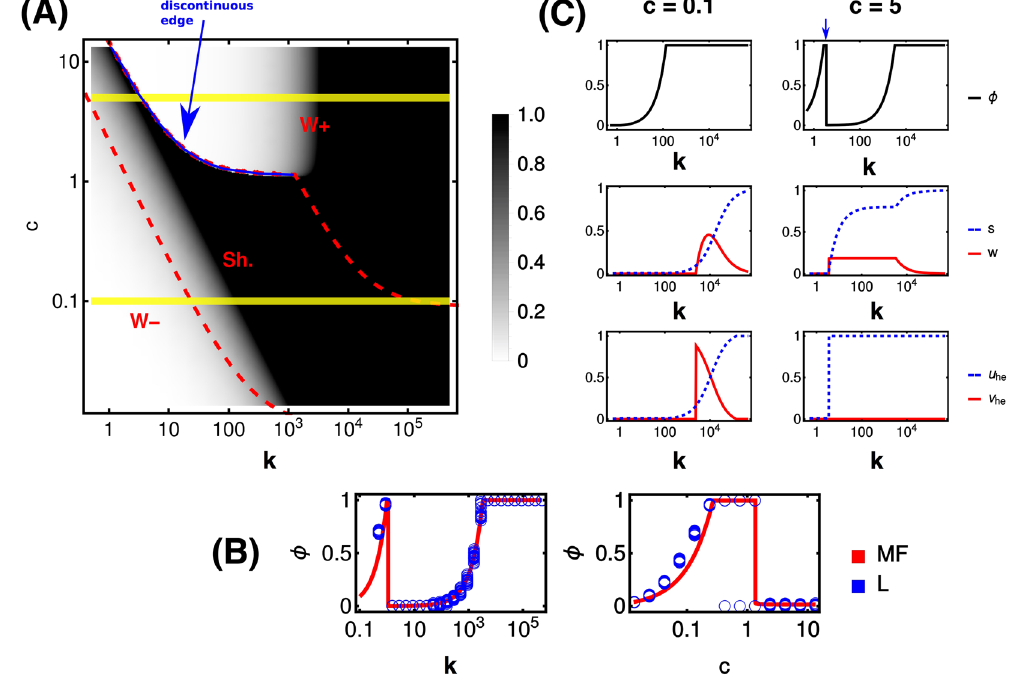
Figure 4. Summary of results for the spatially homogeneous model. ( A ) Fraction φ of aberrant cells (color- coded) as a function of the primary nutrient level in the blood ( c ) and of turn-over rate ( k ). Regions W − , Sh. and W + are as in Fig. 3. The blue line marks the discontinuous transition from a healthy to a fully aberrant tissue at the upper separation between regions Sh. and W + . ( B ) Comparison between the fully spatial and mean-field models. We show φ versus k at fixed c = 7.5 and φ versus c at fixed k = 50 for the former (blue markers, obtained in many different runs) and the latter (red line). ( C ) Fraction of aberrant cells ( φ ), tissue level of primary nutrient ( s ), tissue level of waste ( w ), primary nutrient intake flux by healthy cells ( u ) and waste intake flux by healthy cells ( v ) as a function of k for low (left column) and high (right column) values of c . The blue arrow in top-right plot marks the discontinuous transition highlighted in ( A ). The values of c used in ( C ) are shown by yellow lines in ( A